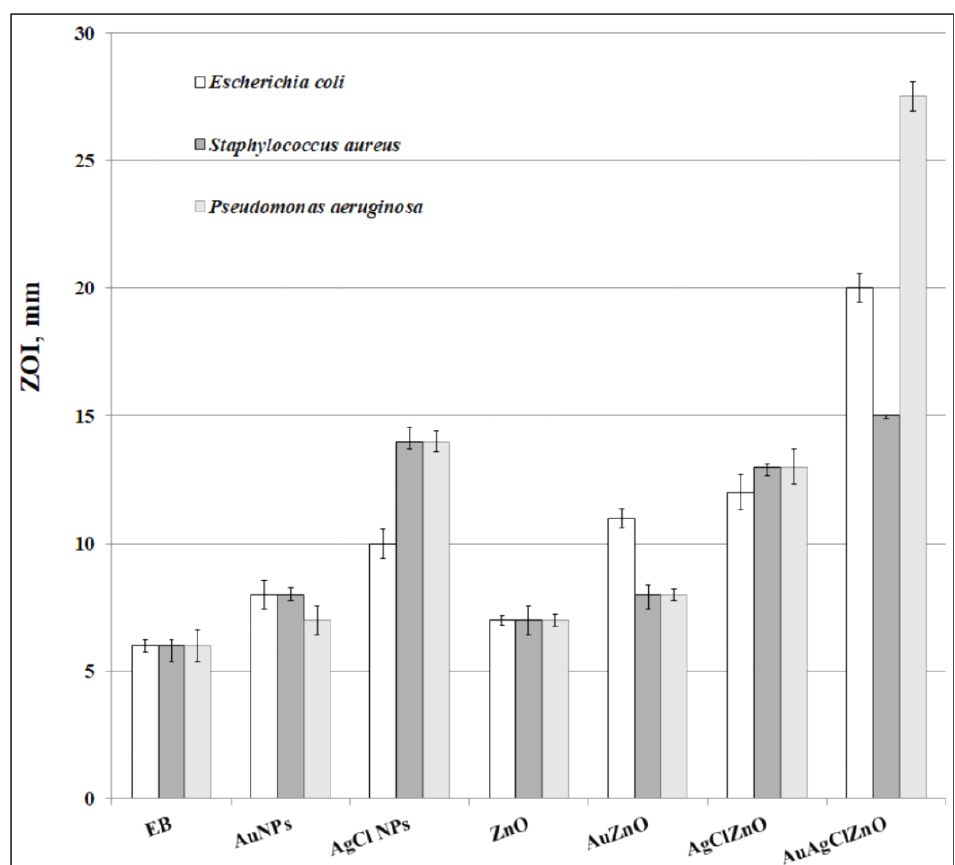
Figure 12. Antibacterial activity (in terms of ZOI values, mm) of burdock-derived samples.